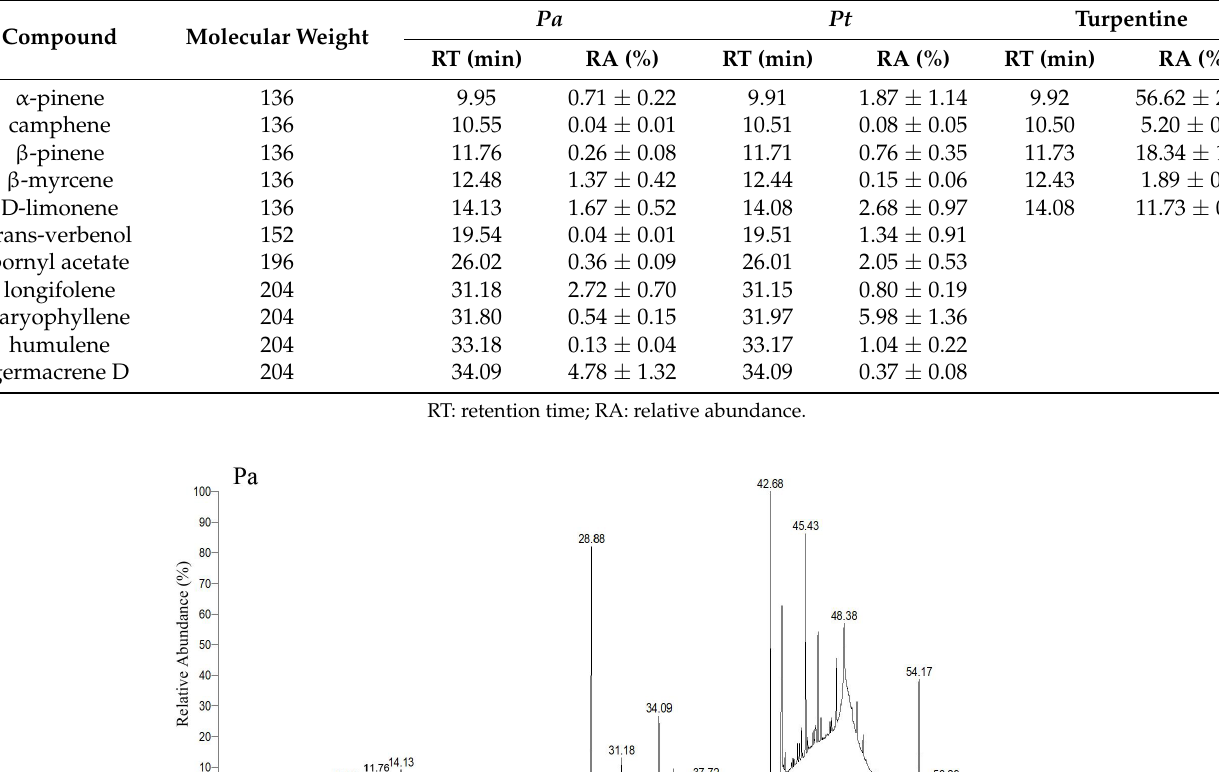
Table 1. The terpenoid compounds’ relative abundance in the bark powders of P. armandii ( Pa ) and , P. tabuliformis ( Pt ), and the main constituents of the turpentine used in this paper.